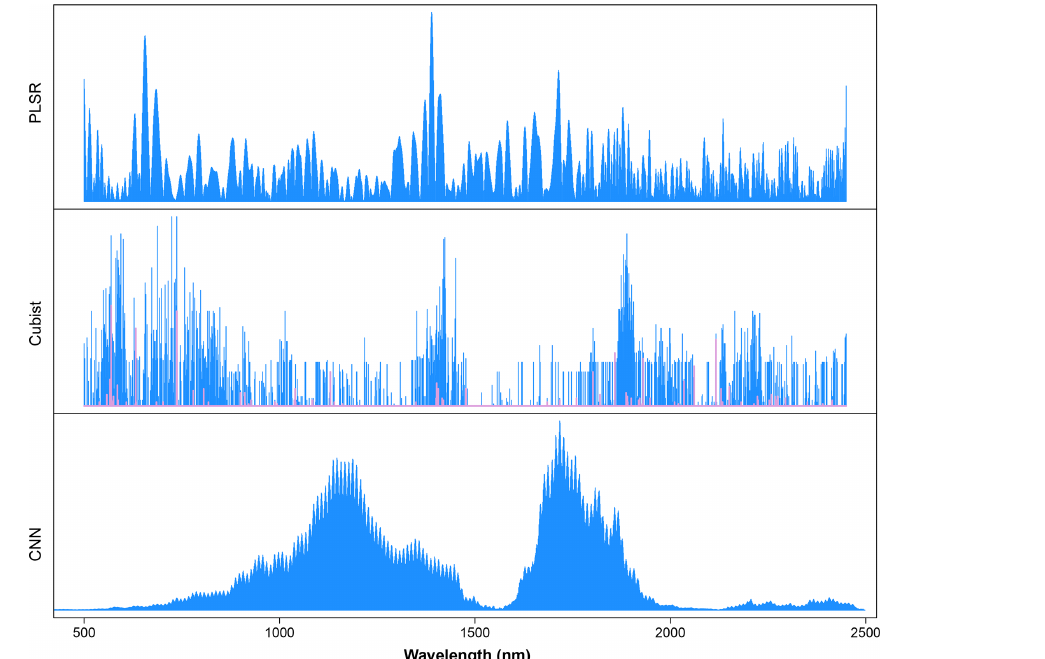
Figure 9. Important wavelengths for the prediction of organic carbon (OC) content using partial least squares regression (PLSR), Cubist and convolutional neural network (CNN)